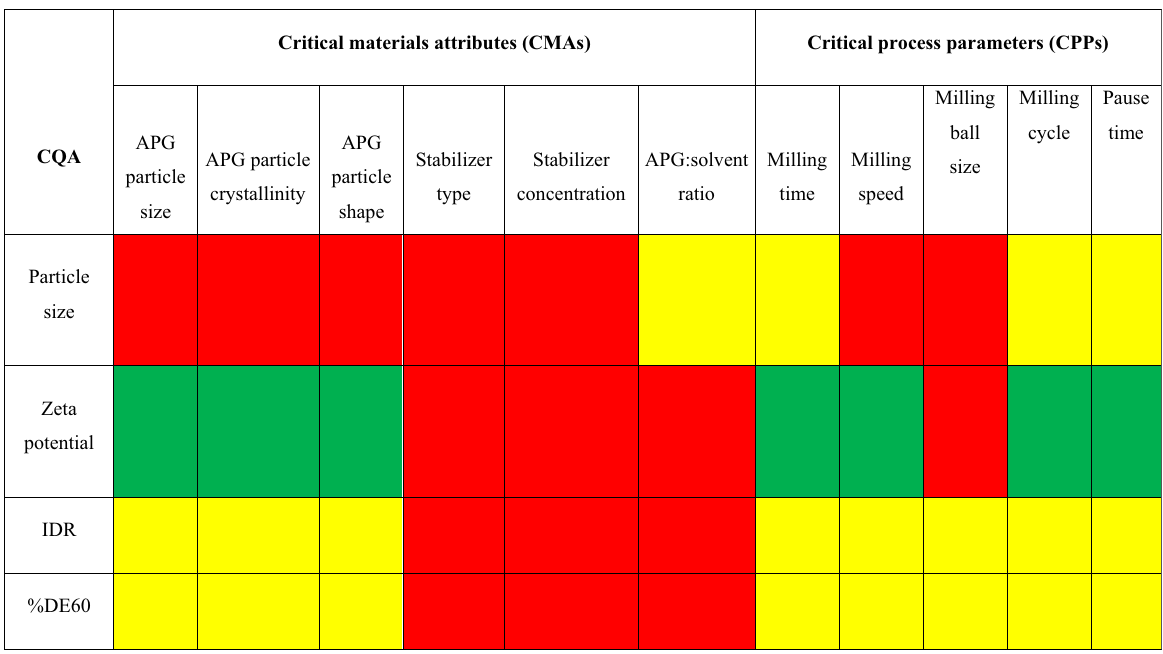
Red color indicates high risk, yellow color – medium risk, and green color – low risk.